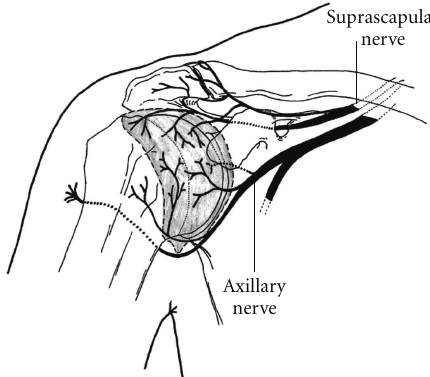
Figure 1: Anterior innervation of the shoulder joint. The supras- capular nerve and axillary nerve are the primary nerves supplying the capsule and the glenohumeral joint (Borgeat and Ekatodramis [1]). (Reprinted with permission from Elsevier.)